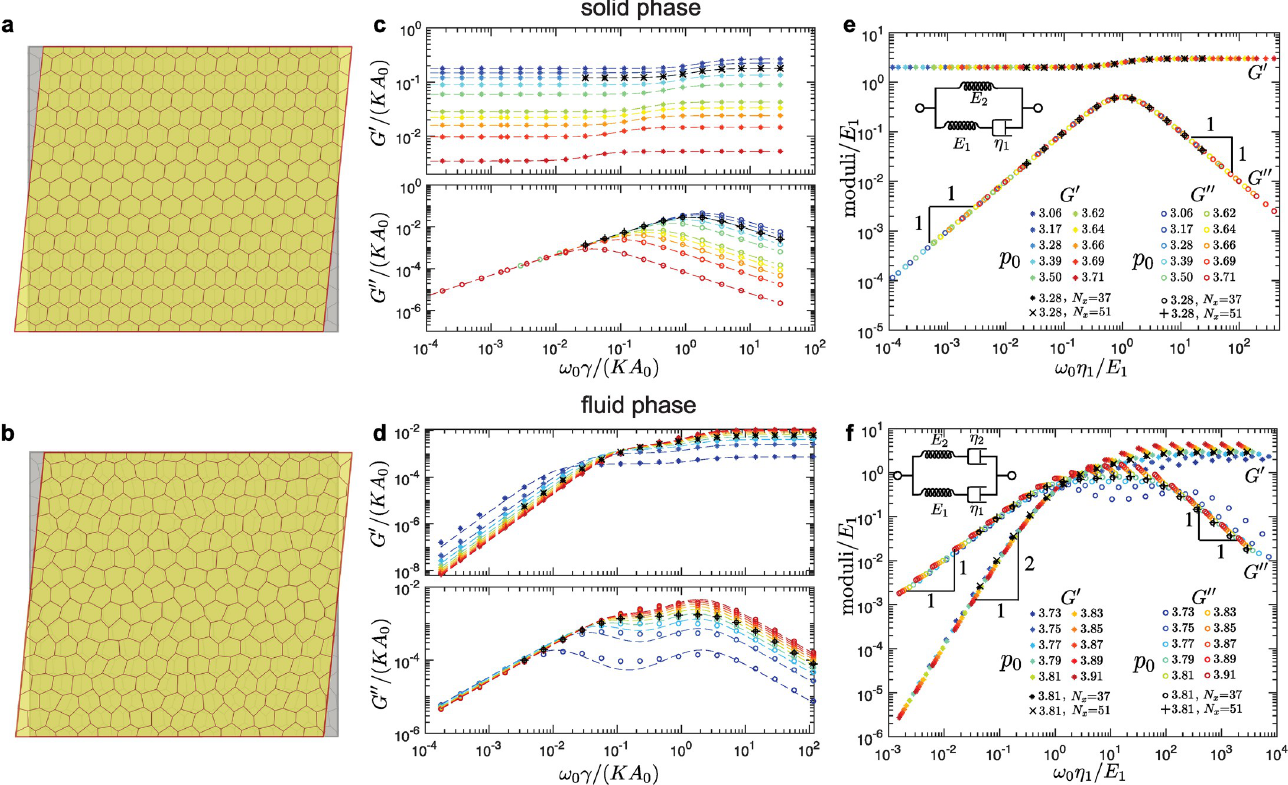
Fig 2. Storage and loss shear moduli in the solid (top row) and fluid phase (bottom row) for hexagonal tilings. (a-b) An overlay of the representative reference (grey) and sheared (yellow) configurations in (a) the solid and (b) the fluid phase. The magnitude of the shear is highly exaggerated for demonstration purposes. (c-d) Representative storage ( G 0 ) and loss ( G 00 ) shear moduli as functions of the shearing frequency, ω 0 , for different values of the cell-shape parameter, p 0 . Dashed curves are the fits based on (c) the Standard Linear Solid (SLS) model in the solid phase [see Eq (5)] and (d) the Burgers model in the fluid phase [see Eq (8)]. (e-f) The collapse of the moduli curves for different values of p 0 for (e) the solid phase and (f) the fluid phase. The insets show the representation of (e) the SLS model and (f) the Burgers model in terms of the springs and dashpots. The majority of the data corresponds to the system of nearly square shape with N x = 15 cells in the horizontal direction, and we also show examples of larger systems with N = 37 and N = 51 cells in the horizontal direction. x x